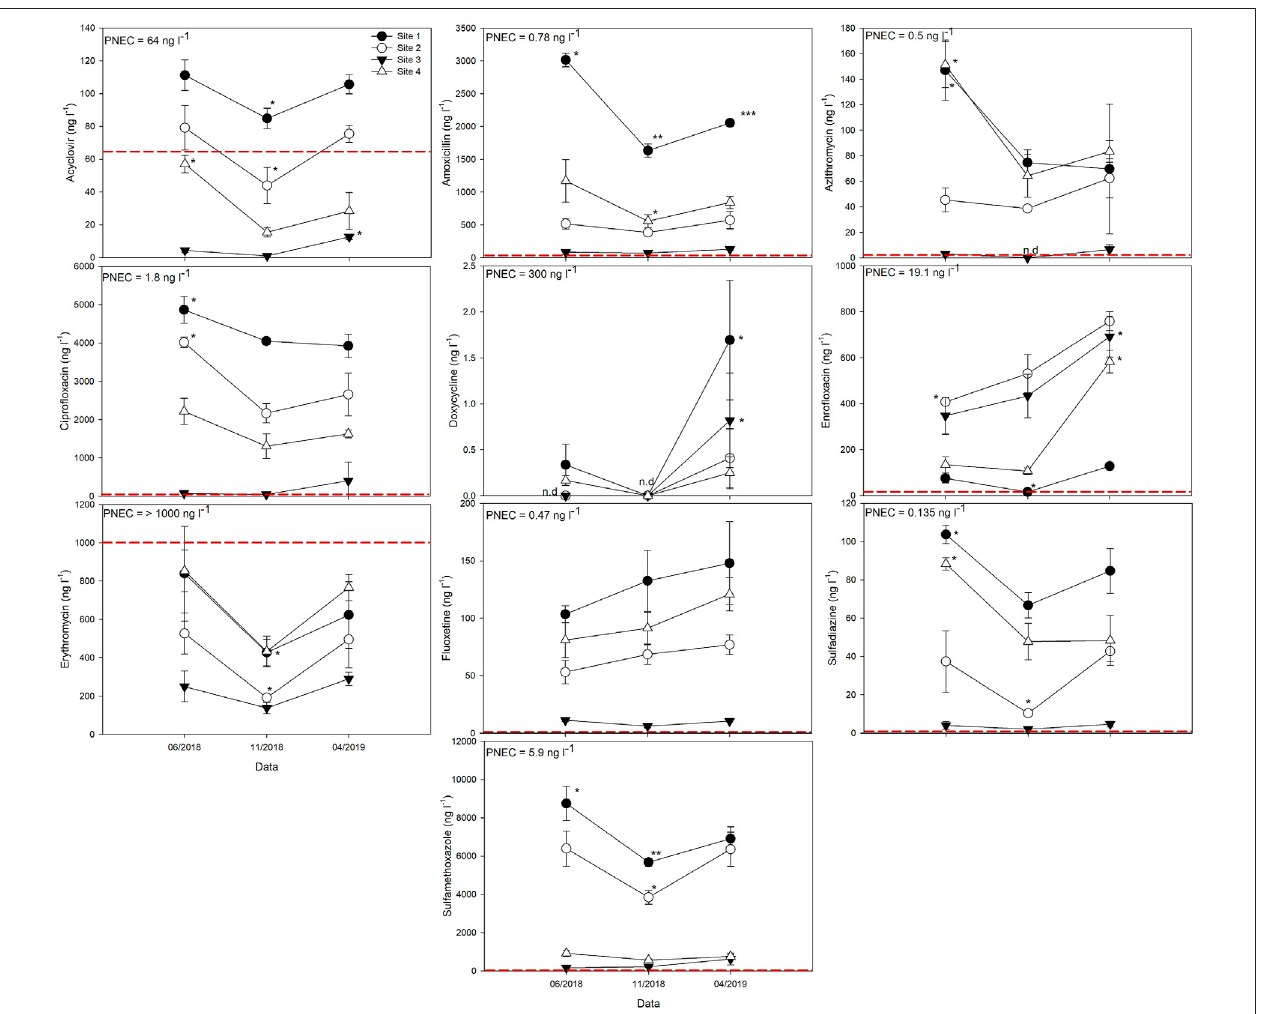
FIGURE 2 | Concentrations of pharmaceutical target products in surface water samples from rivers of the Doce river watershed, Minas Gerais, Brazil. Values are means ± SD of three replicates. Values marked with * differ signi fi cantly ( p < 0.05) within the same sampling site by the contrast test. Predicted no effect concentration (PNEC) is shown as dotted red line. NOEC (cid:2) concentration with no observed effect.